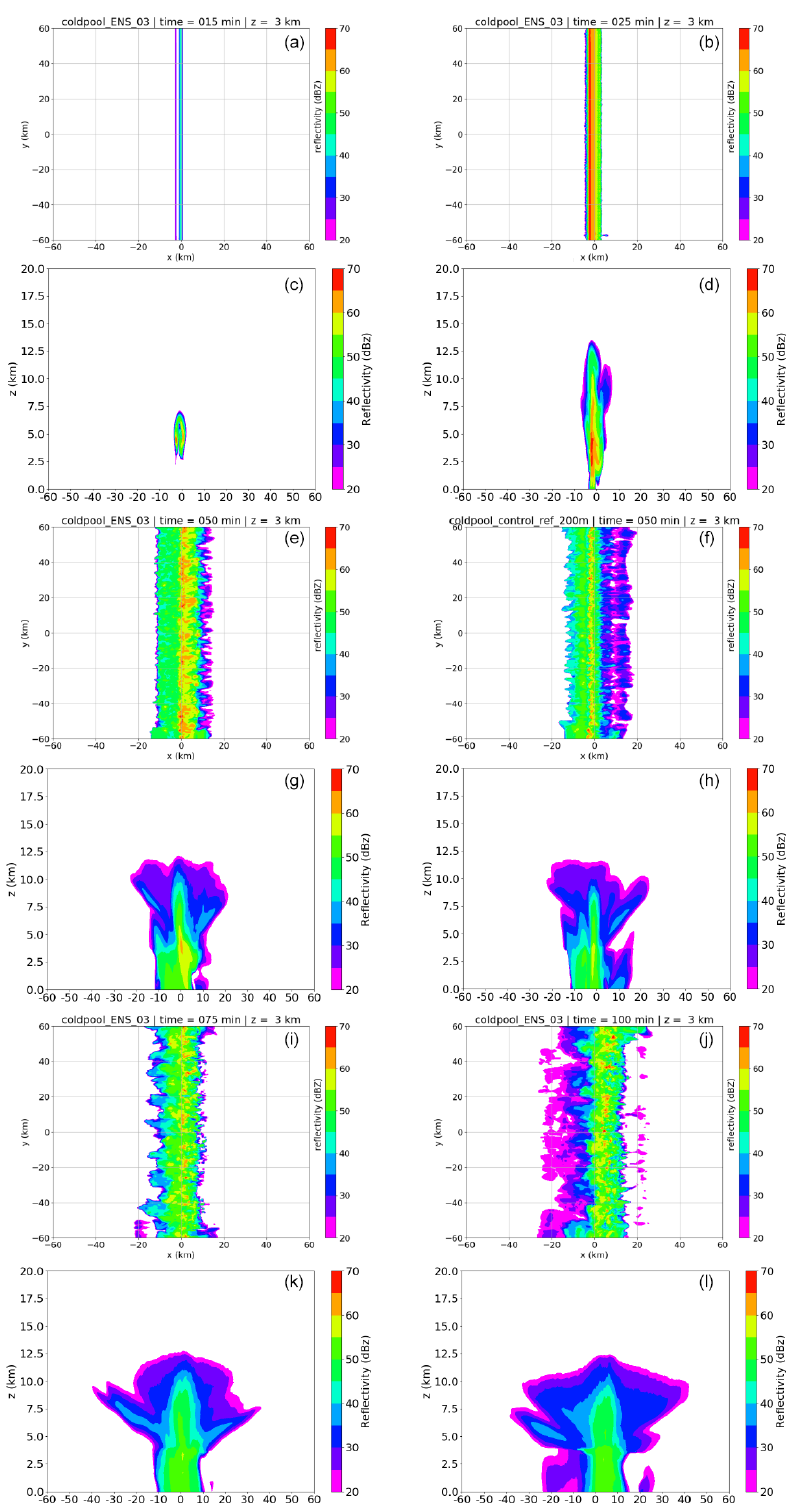
Figure 2. Evolution of simulated reflectivity for ensemble member 3 and the reference simulation (only t = 50min) at z = 3km. A horizontal cross section is followed by corresponding x – z cross section directly below, with median reflectivity along the squall line. Left top (a, c) : t = 15min, right top (b, d) : t = 25min, left centre (e, g) : t = 50min (ensemble member 3), right centre (f, h) t = 50min (reference simulation), left bottom (i, k) : t = 75min, right bottom (j, l) : t = 100min.